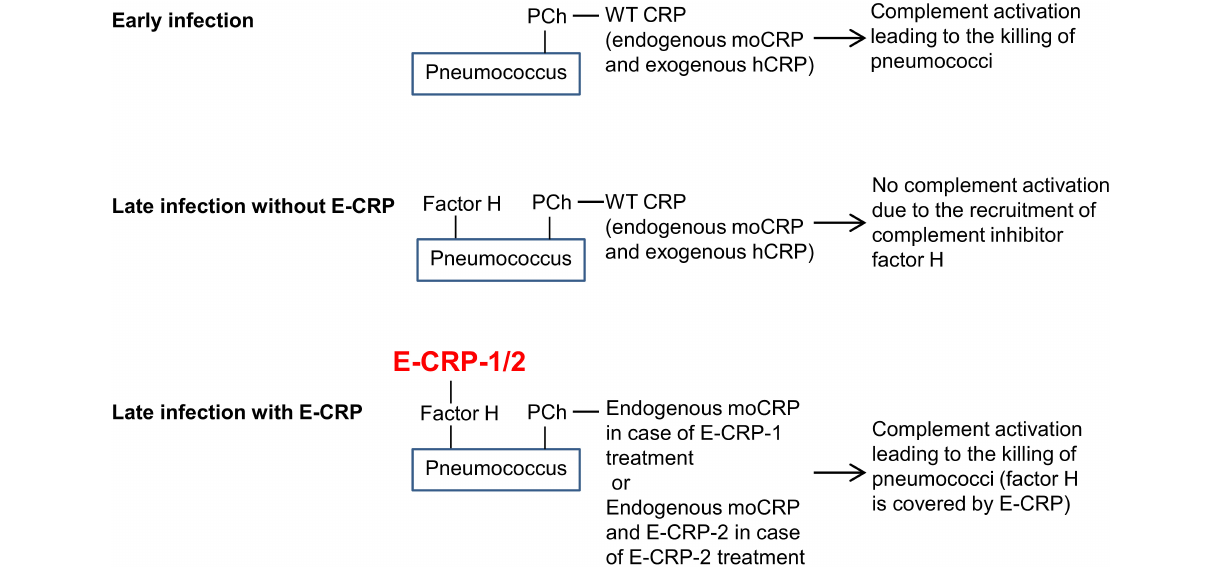
FIGURE 10 | A proposed model for the mechanism of action of CRP in pneumococcal infection. moCRP, endogenous mouse WT CRP; hCRP, exogenously administered human WT